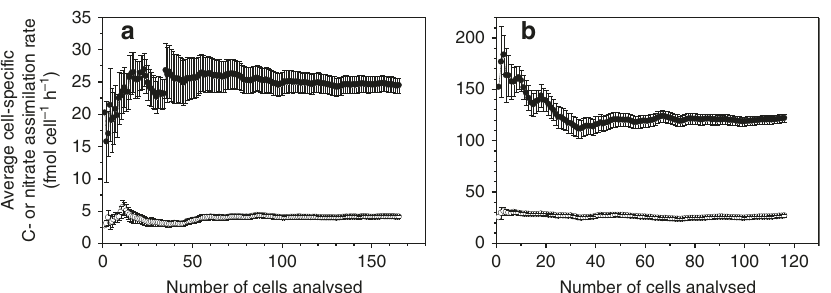
Fig. 7 Average C- and N-assimilation rates as a function of cells analysed. Average cell-speci fi c C-assimilation rate (closed symbols) or nitrate assimilation rate (open symbols) with the standard error of the mean as a function of cells analysed in Skeletonema ( a ) and in Chaetoceros ( b ) under